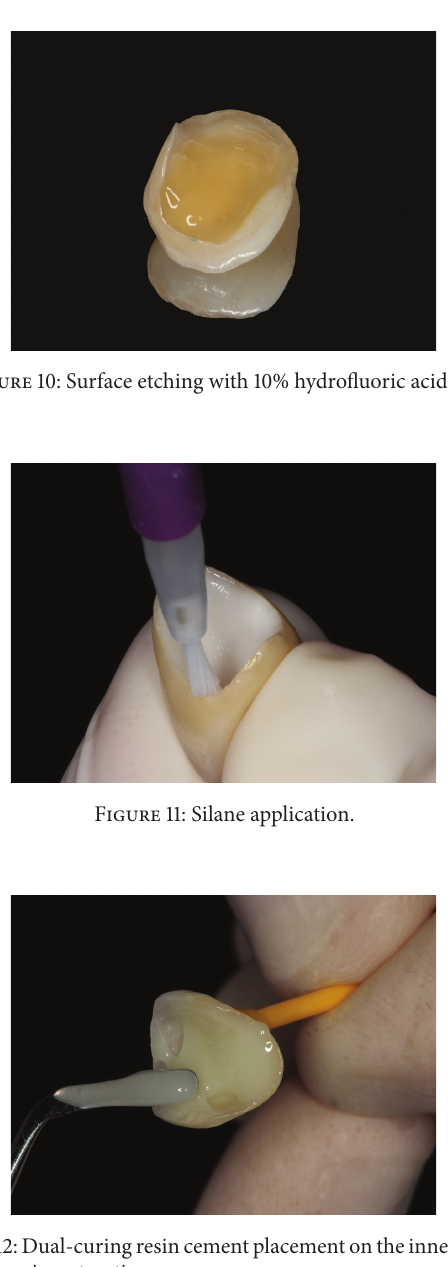
Figure 16: Restorations with lifelike esthetic